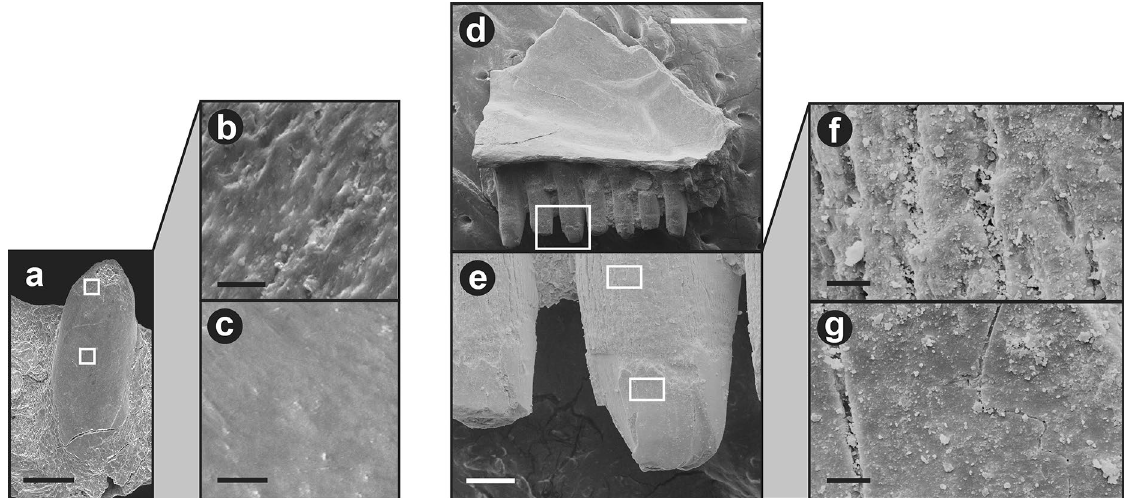
Figure 5. Corrosion damage to teeth of pleurodont lizards from the early Paleogene of Wyoming, USA: ( a – c ) type 1 corrosion (from Big Multi), in which the crown has been completely destroyed (note thinning toward the tip) but the shaft is undamaged, and ( d – f ) type 2 corrosion (from Turtle Graveyard), in which the crown enamel is undamaged (except by breakage, perhaps during screenwashing) but the shaft is corroded. Note also the midline fracture at the lingual base in the